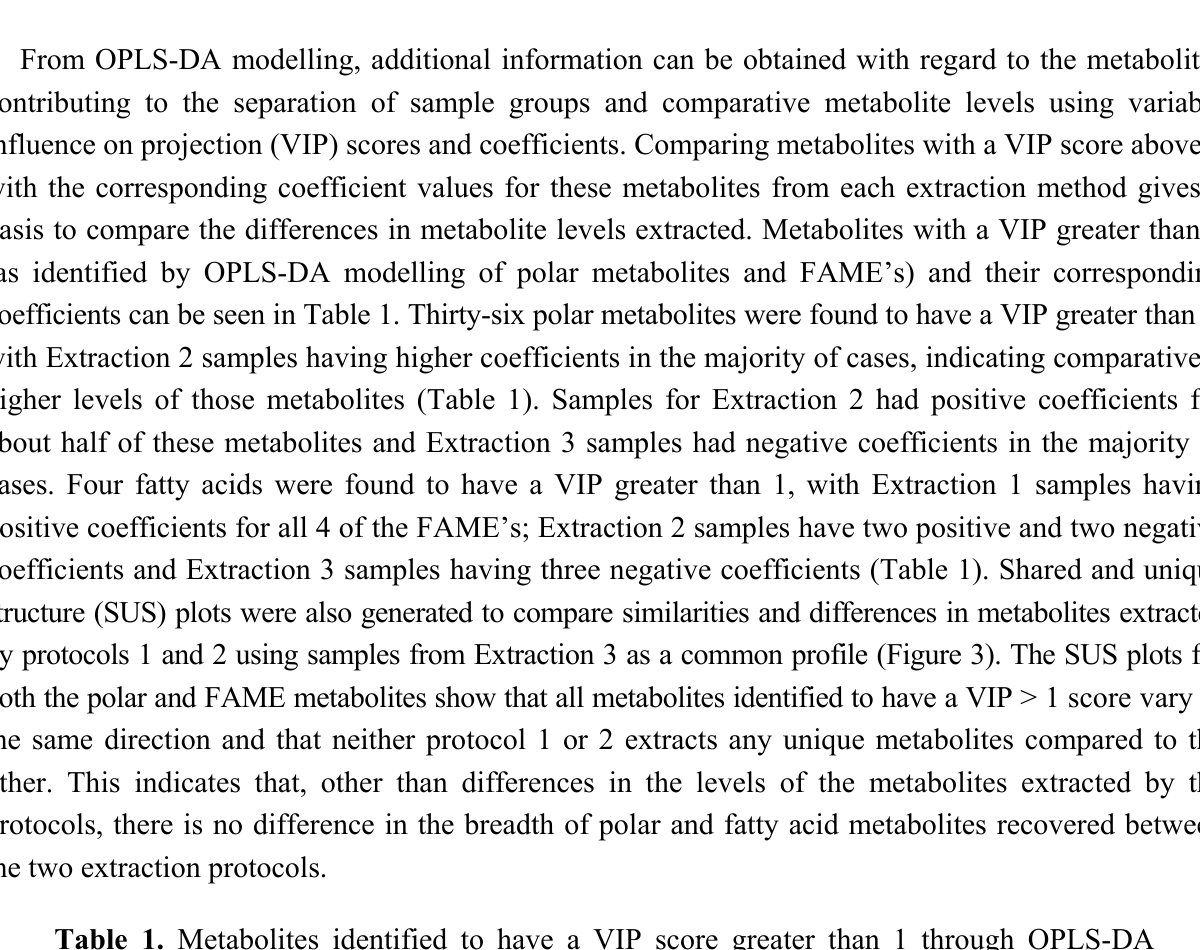
Table 1. Metabolites identified to have a VIP score greater than 1 through OPLS-DA modelling of aqueous metabolite and FAME extraction data and the corresponding coefficient values for each extraction protocol. Values with a positive coefficient indicate higher comparative levels, while values with a negative coefficient indicate lower comparative